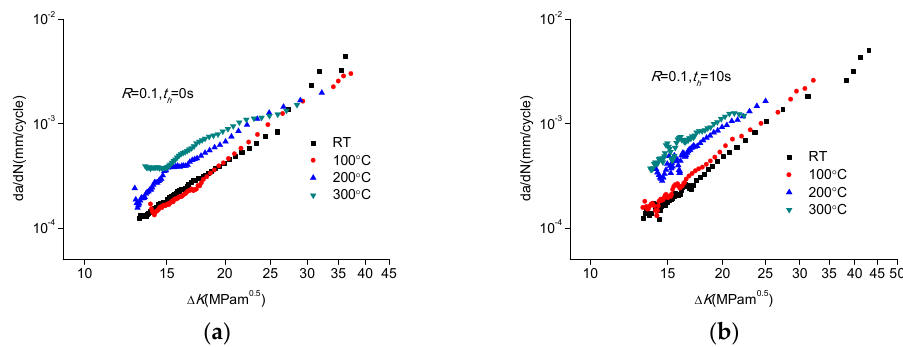
Figure 5. FCG behavior of CP-Ti at different temperatures under low load ratio: ( a ) pure fatigue; ( b ) dwell fatigue.